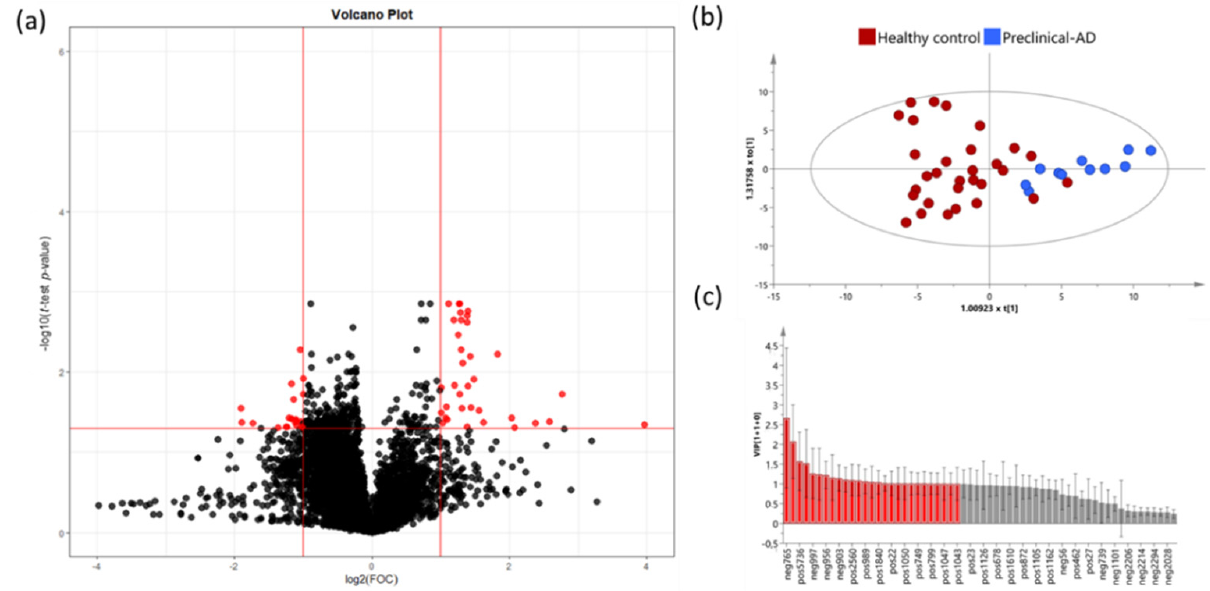
Figure 4. ( a ) Volcano Plot representing the significant variables in the discrimination between healthy controls and preclinical AD participants. Statistically significant variables are represented in red ( p < 0.05, FC > 2); ( b ) OPLS-DA plot represents differential distribution between healthy controls and preclinical AD; ( c ) Threshold VIP plot value > 1 (red